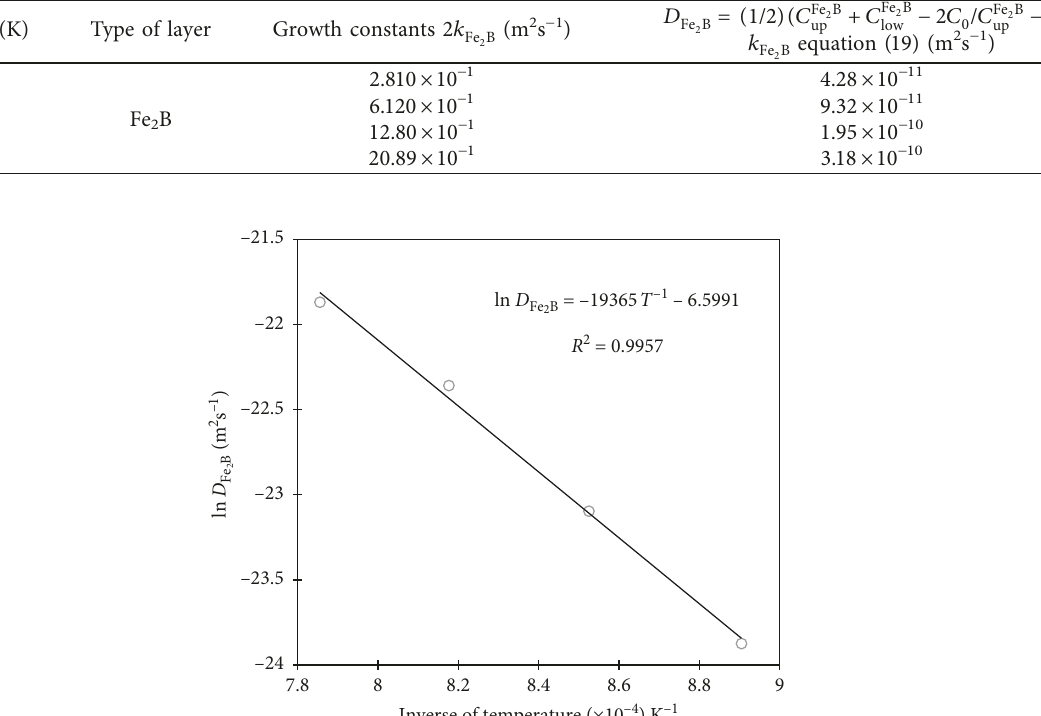
Table 1: Experimental values of parabolic growth constants at the (Fe 2 B/substrate) interface in the range of 1123–1273K and estimated values of boron diffusion coefficients in the Fe 2 B layers by using the first approach.